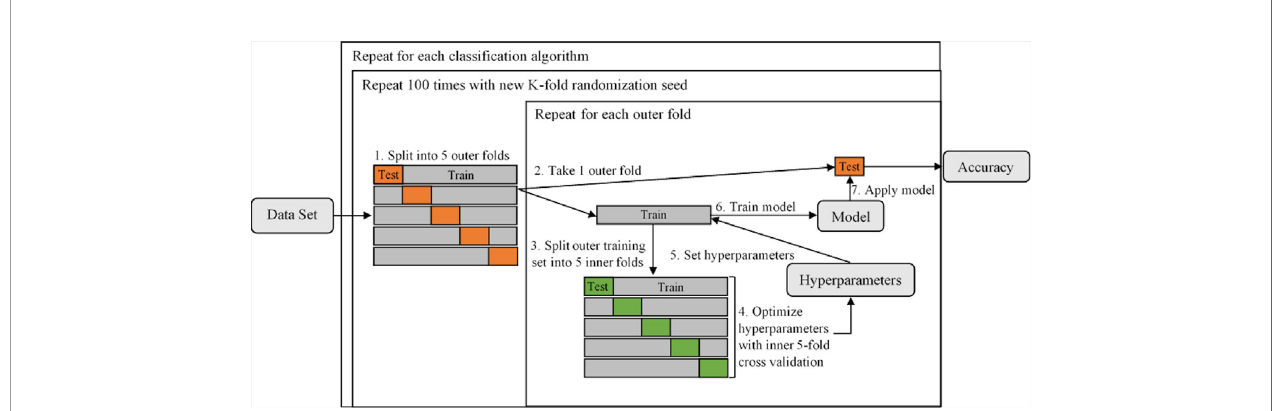
FIGURE 3 | A diagram illustrating the process of tuning hyperparameters and determining individual model performance using nested 5-fold cross-validation. The dataset is fi rst split into fi ve outer folds (Step 1), each acting once as the test set and the remaining four times as a component of the training set. The training set is then split into fi ve inner folds (Steps 2 and 3, repeated for each of the outer folds), on which the hyperparameters are tuned (Step 4). Both inner and outer 5-fold cross- validation utilized the KFold function in Scikit-Learn (parameters were set to n_splits = 5, shuf fl e = True, random_state = iteration number). The optimal hyperparameteres are then set (Step 5) and the individual model is trained on the outer training set (Step 6) and performance is evaluated on the outer test set (Step